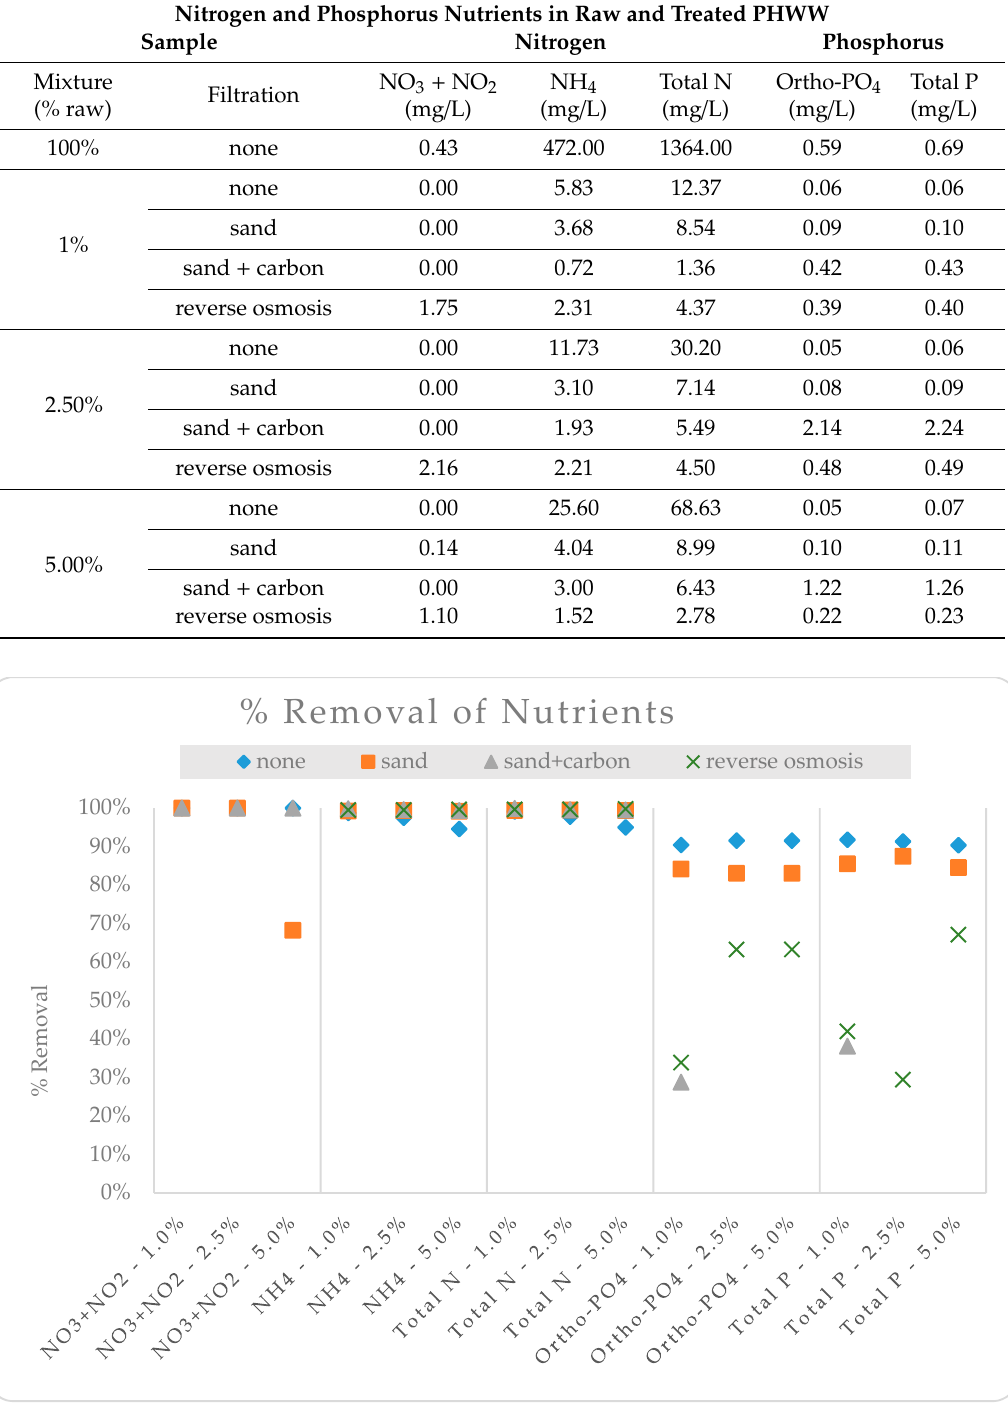
Figure 6. The percent removal of each form of nitrogen and phosphorus from the raw PHWW for the four treatments.